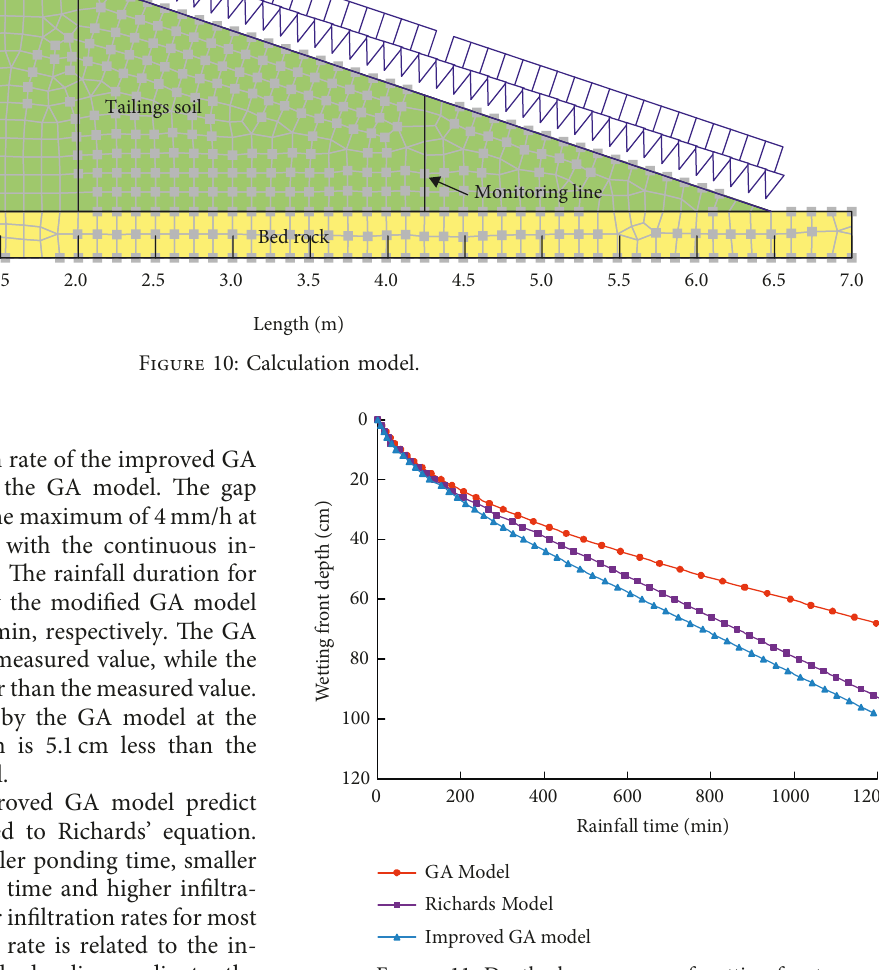
Figure 11: Depth change curve of wetting